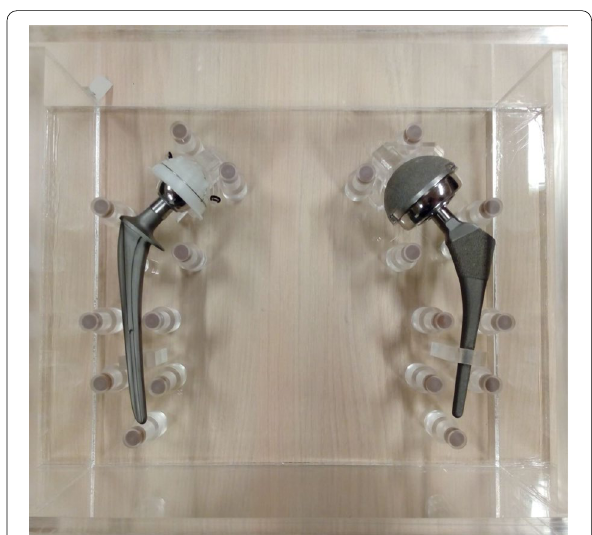
Fig. 1 Image of the phantom containing bilateral prostheses at the right (cup: UHMWPE, head: ZTA, stem: CoCrMo) and left (cup: CoCrMo, head: CoCrMo, stem: TiAlV). UHMWPE ultrahigh molecular weight erthylene, ZTA Zirconia toughened aluminum, TiAlV